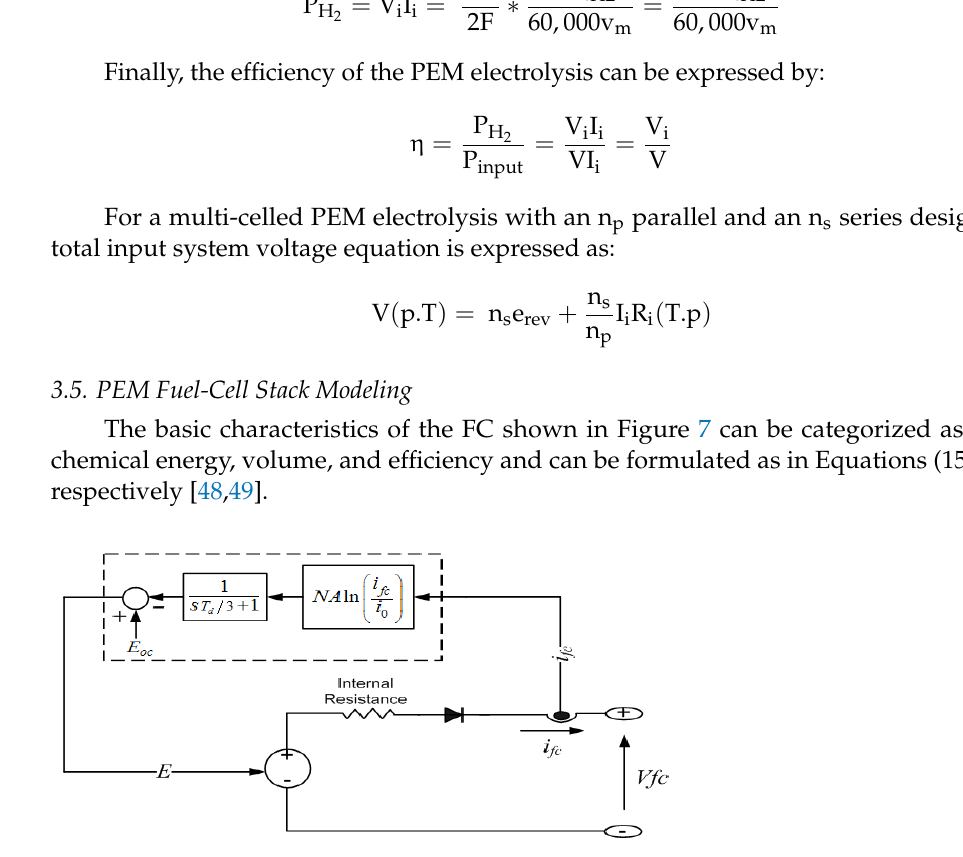
Figure 7. Electrical circuit equivalent circuit.